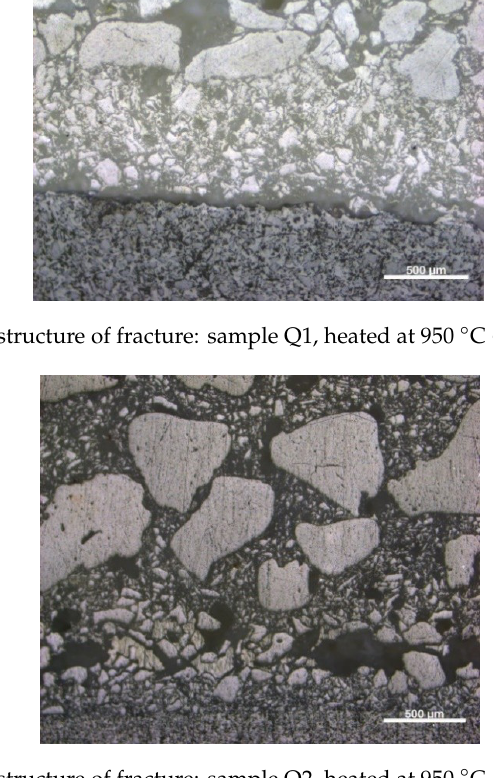
Figure 9. Microstructure of fracture: sample Q2, heated at 950 °C (light microscopy).